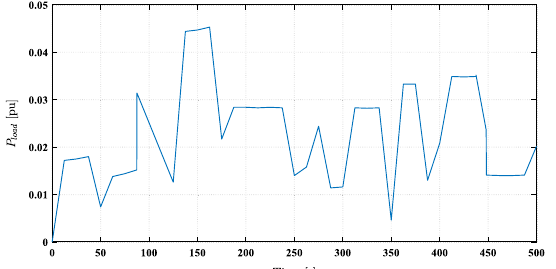
Fig. 18 The load power fluctuation of Case 4